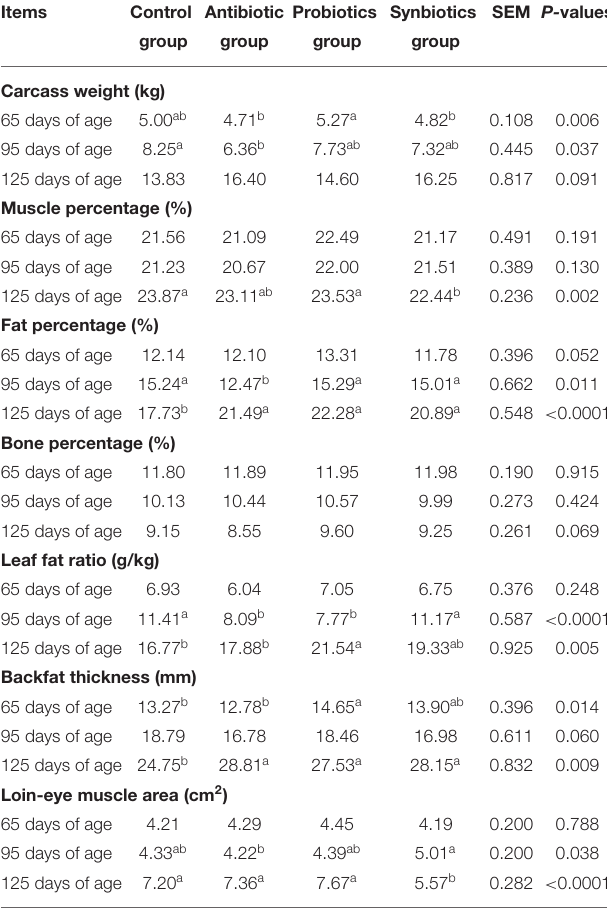
TABLE 2 | Effects of probiotics and synbiotics addition in sows’ diets on carcass traits of offspring pigs.